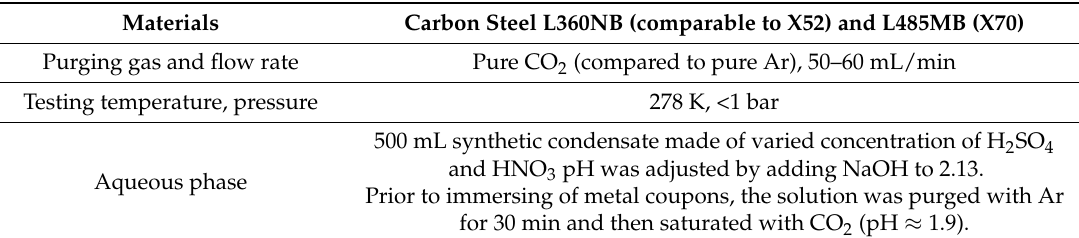
Table 2. Experimental